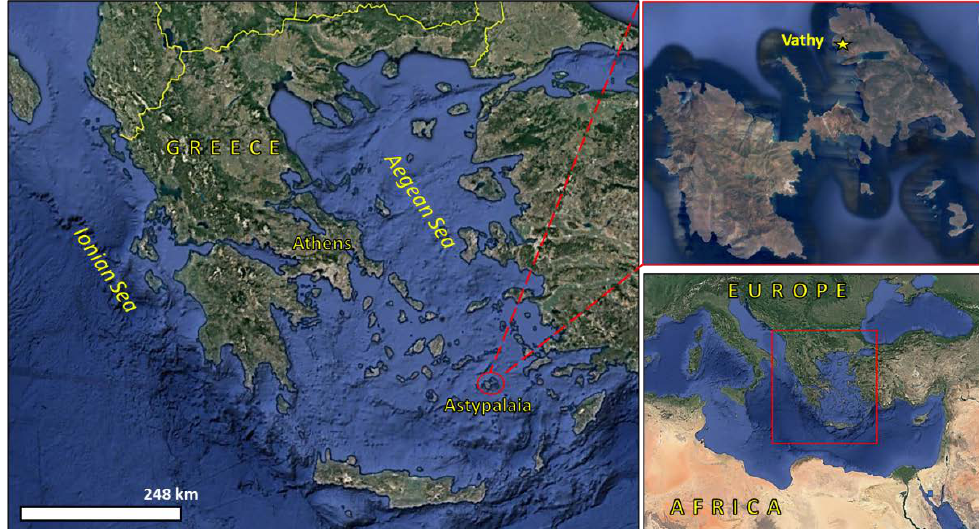
Figure 1. Oblique satellite view (Google Earth Pro) of Greece and Astypalaia Island in the Aegean Sea.